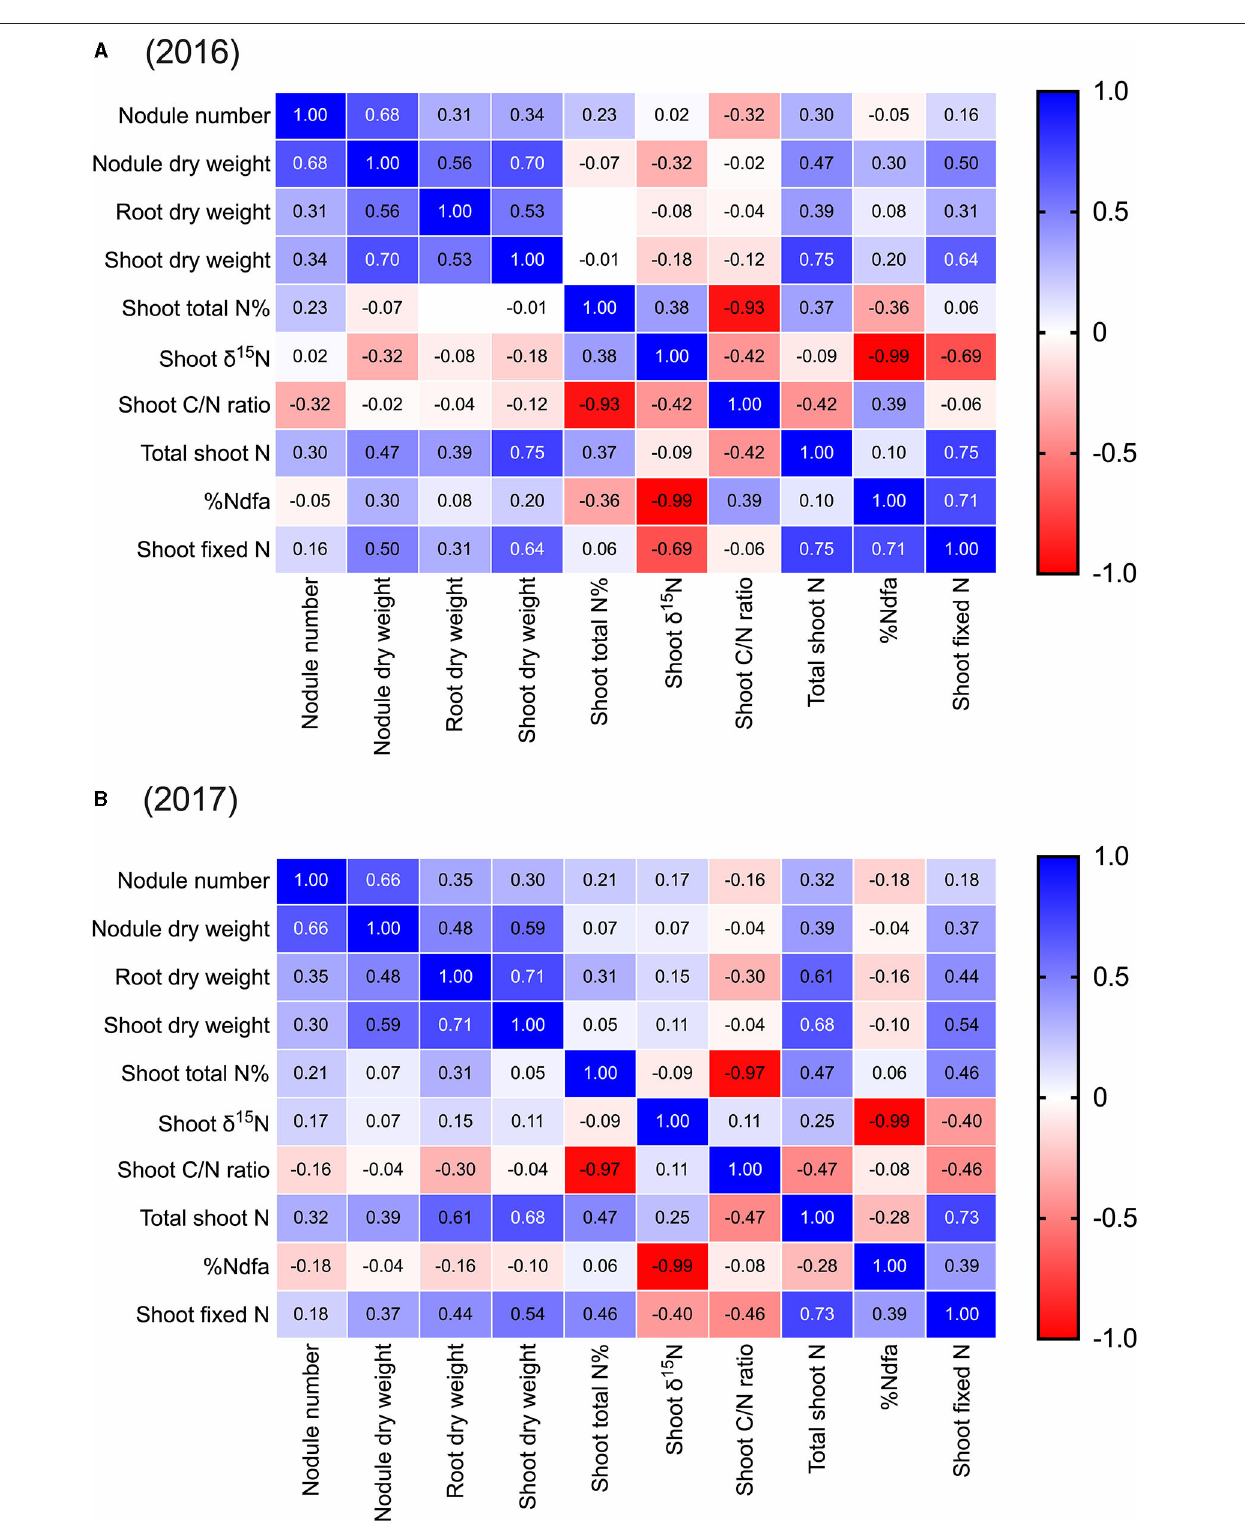
Frontiers in Agronomy |